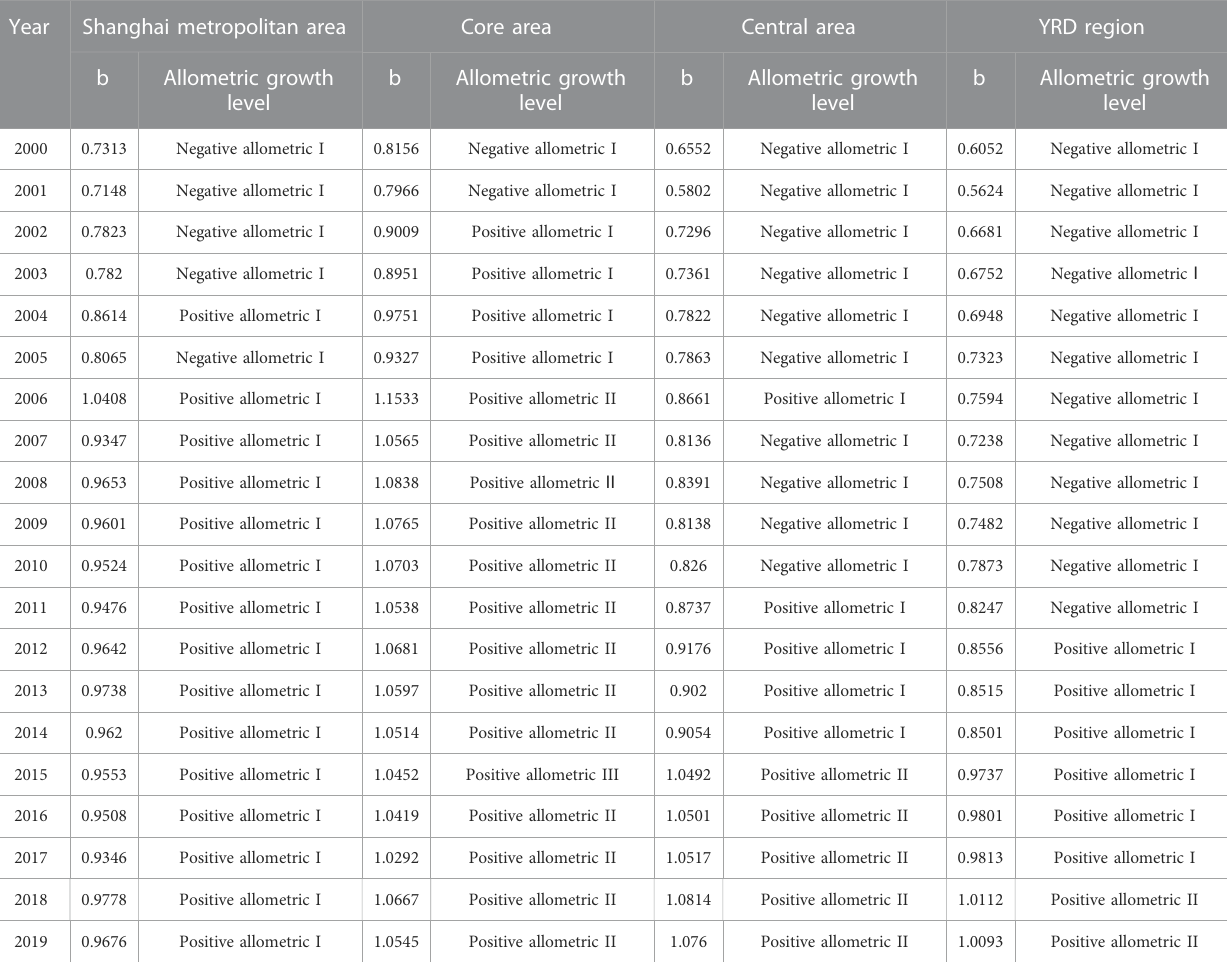
TABLE 3 Results of the population-land allometric growth fi tting in the YRD